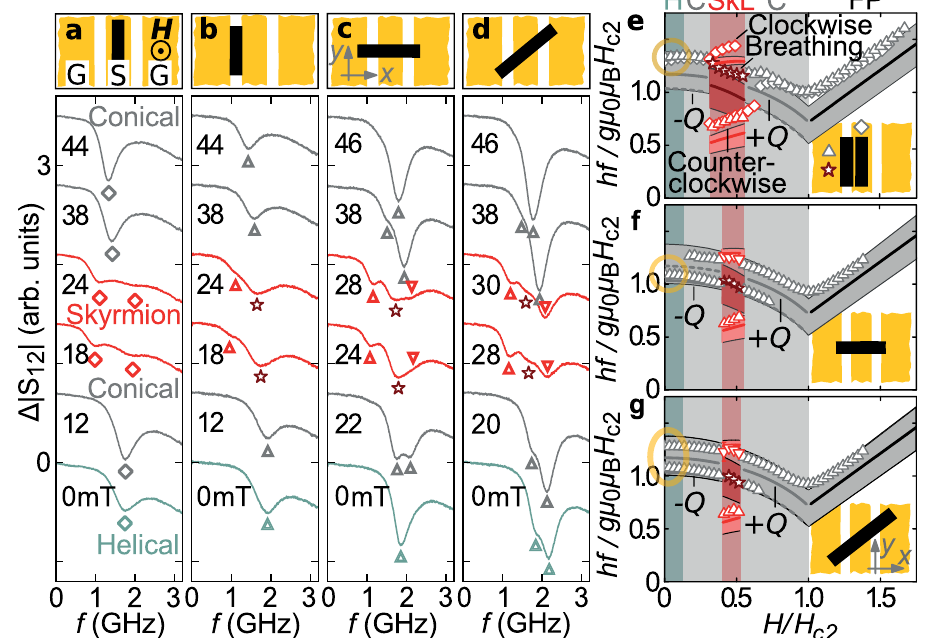
Figure 2. Spin resonance data and comparison with theory. ( a–d ) Typical spectra Δ | S 12 | in arbitrary units with the sample positioned differently on the CPW as sketched on top of each panel. Data are shown for different applied field values in the helical, conical, and SkL phase and are offset for clarity. The field is applied along the 〈 100 〉 direction. Symbols indicate resonance frequencies. ( e–g ) Comparison of measured and calculated resonance frequencies. Lines and shaded bands correspond to calculations with k = 0 and magnetostatic waves with small k ≠ 0, respectively 22 . Dashed lines indicate modes with small spectral weight. Circles highlight that a different number of modes is resolved at small H